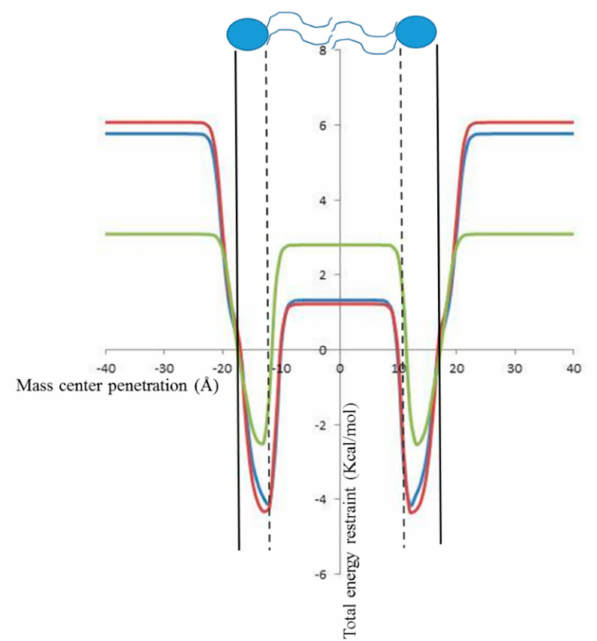
Figure 3. Evolution of the total restraint as a function of the molecule mass center penetration in an implicit bilayer obtained by IMPALA. The vertical black line corresponds to the interface between the lipid heads and the aqueous phase ( z = 18 Å), the dotted line represents the interface between the lipid hydrocarbon chain and the hydrophilic head ( z = 13.5 Å), and the center of the bilayer is at 0 Å. A cartoon of two lipid molecules (in blue) is presented to better visualize the di ff erent interfaces. Red curve: CitO, blue curve, CitA, green curve: CIN.